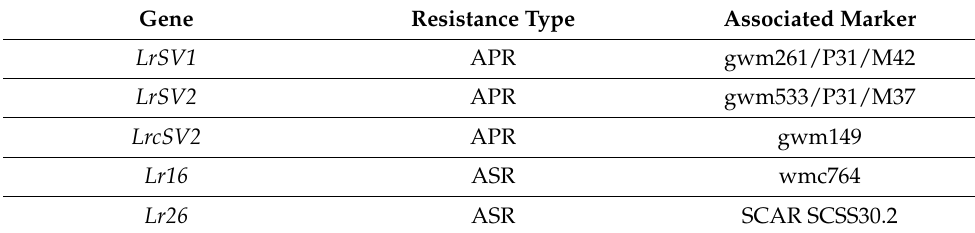
Table 3. Molecular markers used to assist the selection of the indicated